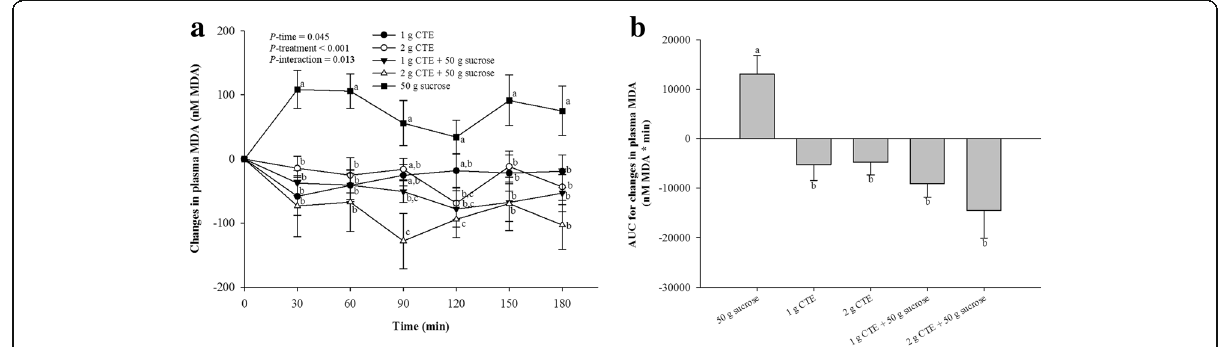
Fig. 7 Postprandial plasma MDA of five different beverages. a Changes in MDA concentrations during 180 min of five different beverages; ( b ) MDA changes area under the curves (AUCs) of five different beverages. Values are means ± SEM, n = 15. Different letters are significantly different ( P < 0.05)